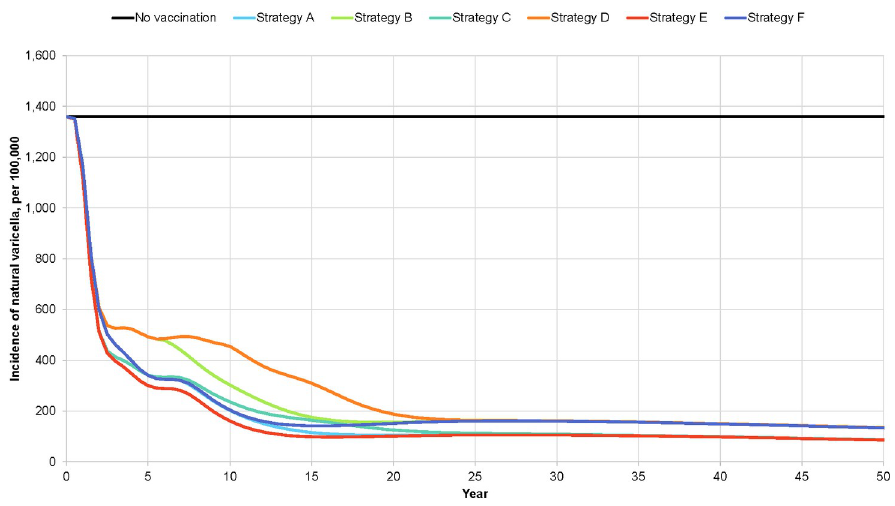
Fig 2. Projected incidence of total varicella, by varicella vaccination strategy.